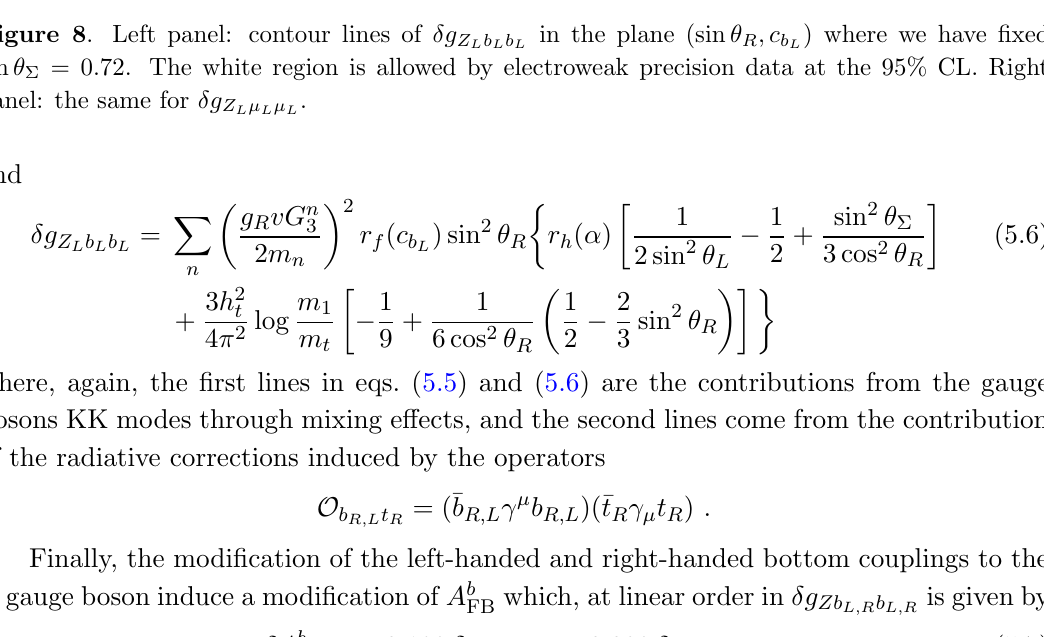
in the plane (sin (cid:18) R ; c b ) where we have (cid:12)xed L b L b L L